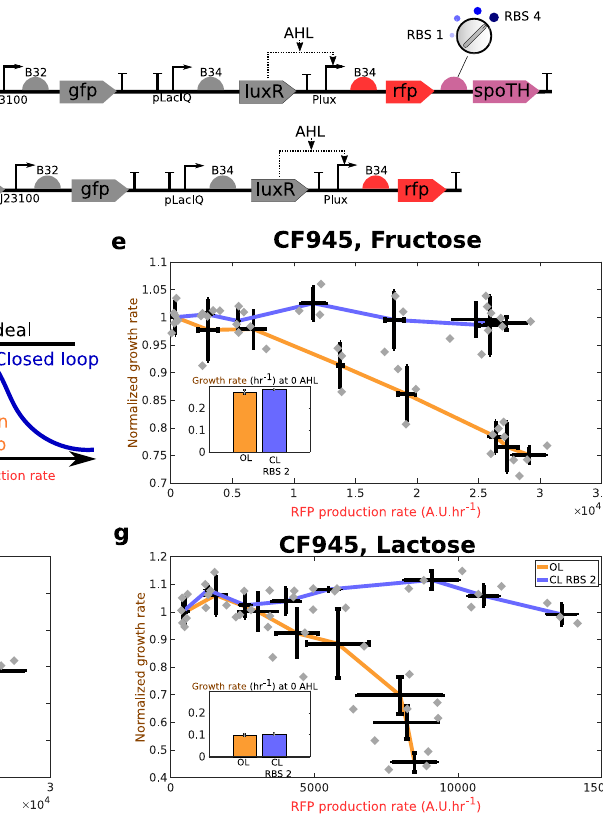
normalized by the growth rate at 0nM AHL (nominal growth rate) versus the RFP production rate for the OL and CL systems, using fructose ( e ), glycerol ( f ), and lactose ( g ) as the carbon source. The inset shows the nominal growth rate with no AHL induction. Data for all the RBS ’ s of the CL system tested, AHL induction con- centrations used,and GFP production data are shown in Supplementary Fig. 2 and Supplementary Fig. 3. Data are shown asthe mean±one standard deviation ( N =3, three biological replicates). Individual experimental values are presented as gray dots. All experiments were performed in the CF945 strain. The complete experi- mental protocol is provided in the Materials and Methods section. Plasmid description, plasmid map, and essential DNA sequences are provided in Supple- mentary Information section Plasmid maps and DNA sequences